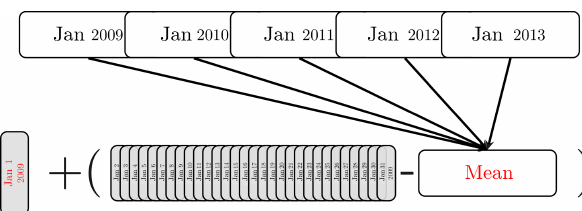
Figure 3. Schematic representation of the methodology used to generate the initial ensemble. MEAN is the January averages over 5 years between 2009 and